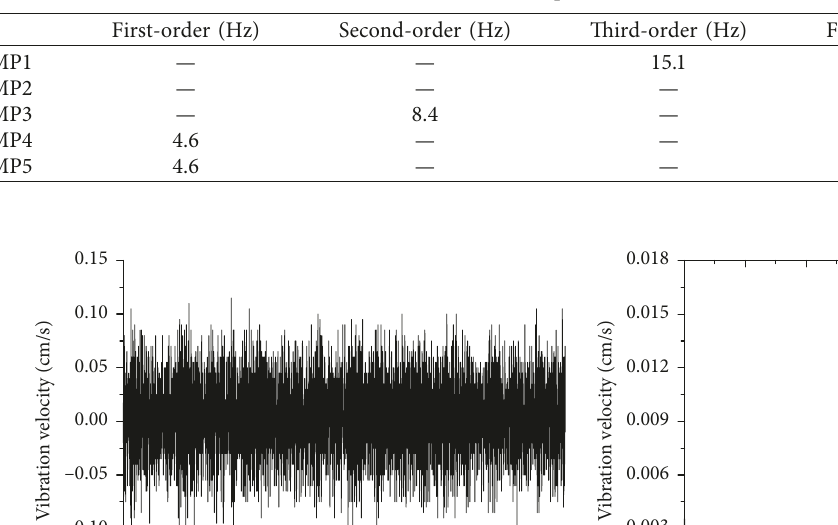
Figure 14: Time-domain waveform and spectrum of MP1: (a) time-domain waveform under excitation; (b) spectrum. Table 3: Structural natural frequencies measured at all measuring points.